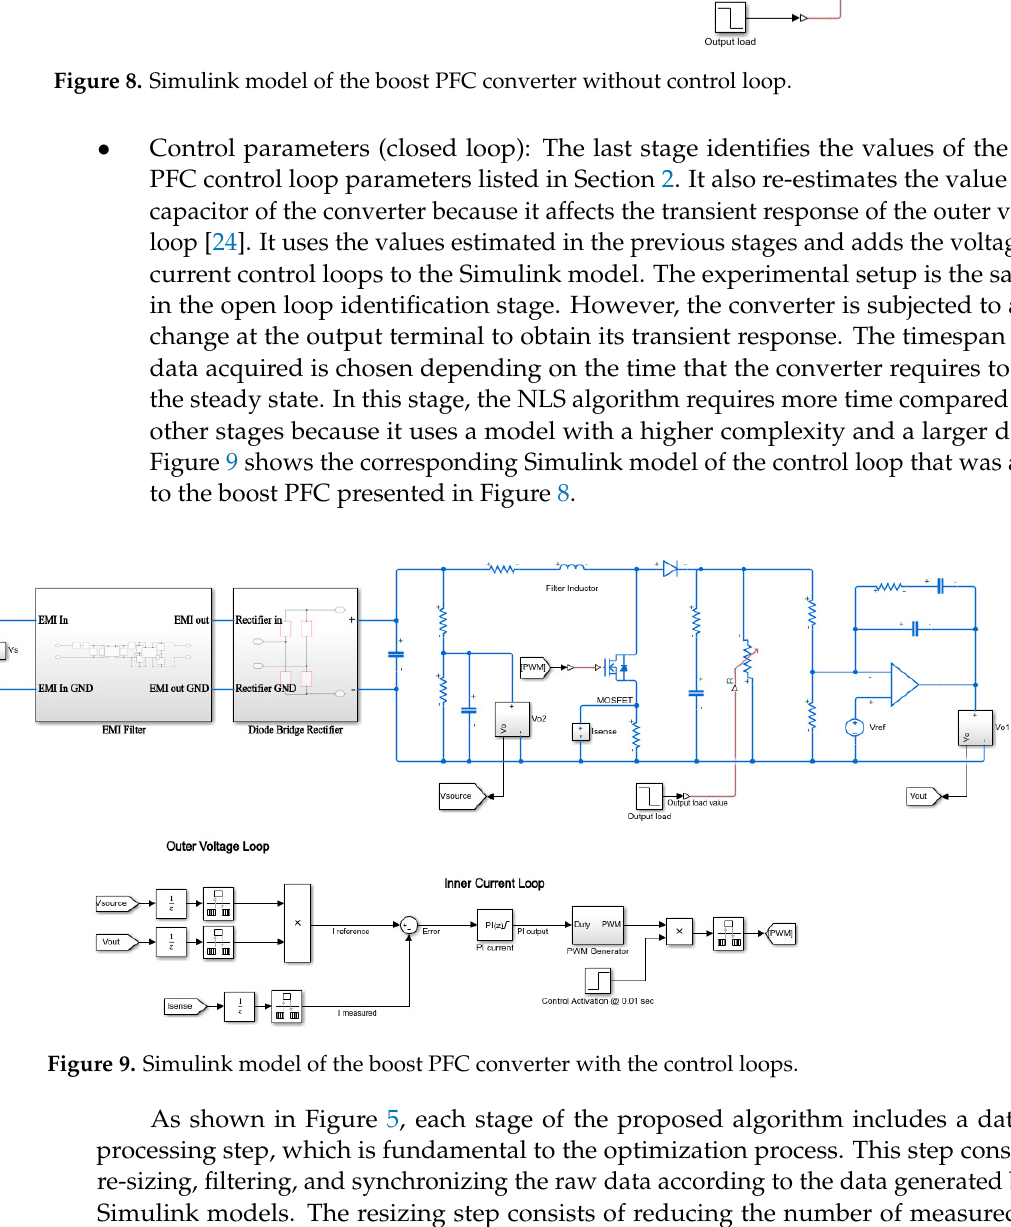
Figure 9. Simulink model of the boost PFC converter with the control loops.